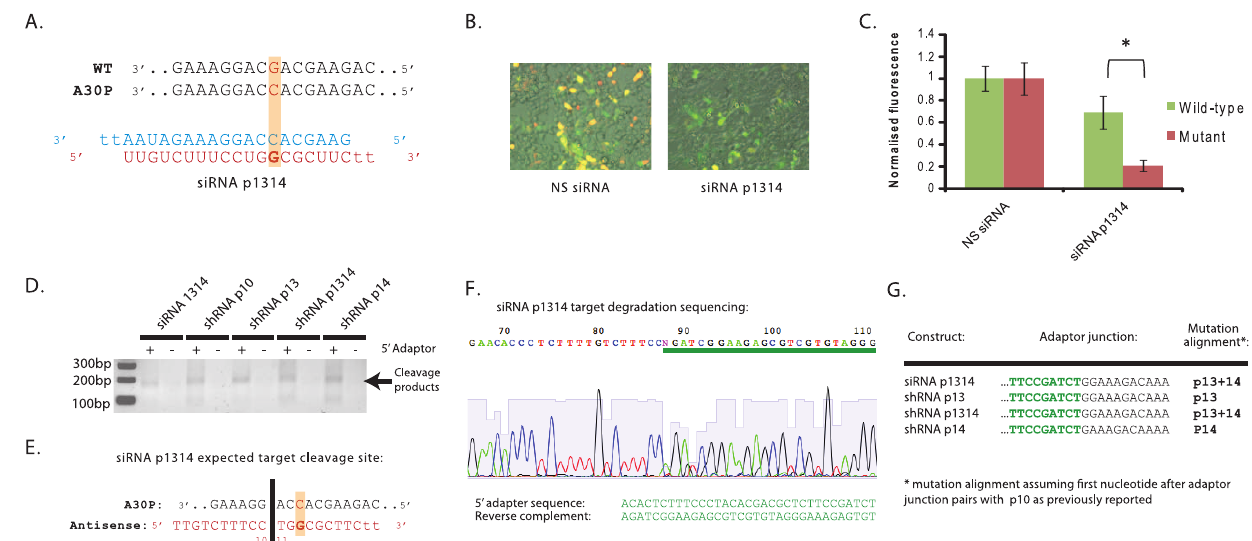
Figure 3. Determination of A30P mutation alignment with siRNA and 5 9 RACE. A) siRNA design with A30P mutation aligned opposite P13 of the antisense species, and secondary mismatch to the wild-type a -synuclein allele at P14. B) Representative merged fluorescent images of HEK-293 cells co-transfected with the Het-A30P plasmid siRNA-1314 at 48 hrs post-transfection. C) Quantification of wild-type a -synuclein eGFP (green bars) or A30P mutant a -synuclein mCherry (red bars) fluorescence at 48 hrs post-transfection following co-transfection of siRNA-1314 with the Het-A30P plasmid. Values represent mean ratios of normalized fluorescence + / 2 S.D. from n=6. Values are normalized to respective fluorescence in cells transfected with non-specific siRNA. *=P , 0.05 relative to respective normalising control. D) Visualisation of PCR products following 5 9 RACE using RNA from cells transfected with mCherry-tagged A30P mutant a -synuclein and stated constructs. Products were run on a 2% agarose gel. E) Expected target cleavage site for siRNA-1314. F) Sequencing of siRNA-1314 PCR product following 5 9 RACE. G) Mapping of 5 9 adaptor ligations sites, determination of target cleavage sites and determination of A30P mutation alignments in stated constructs.